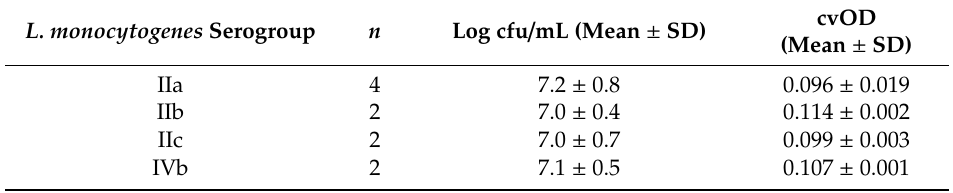
Table 3. Biofilm-forming ability of L. monocytogenes strains according to the respective serogroups.